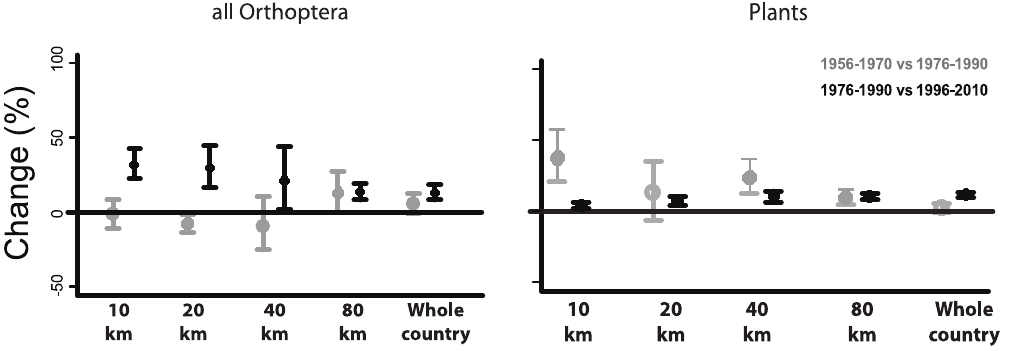
Figure 2. Trends in species richness change ( D S% + 2 95% confidence intervals) for Orthoptera and plant species. Trends at the 10, 20, 40, 80 km grids and all Netherlands. In grey: changes between 1956–1970 and 1976–1990. In black: changes between 1976–1990 and 1996–2010. See table 1 for the numbers of grid cells. Filled symbols indicate change of significantly diffrent from zero; open symbols indicate that change was not significantly different from zero. A pair of results is considered not to be significantly different if the 95% error bars do not overlap.